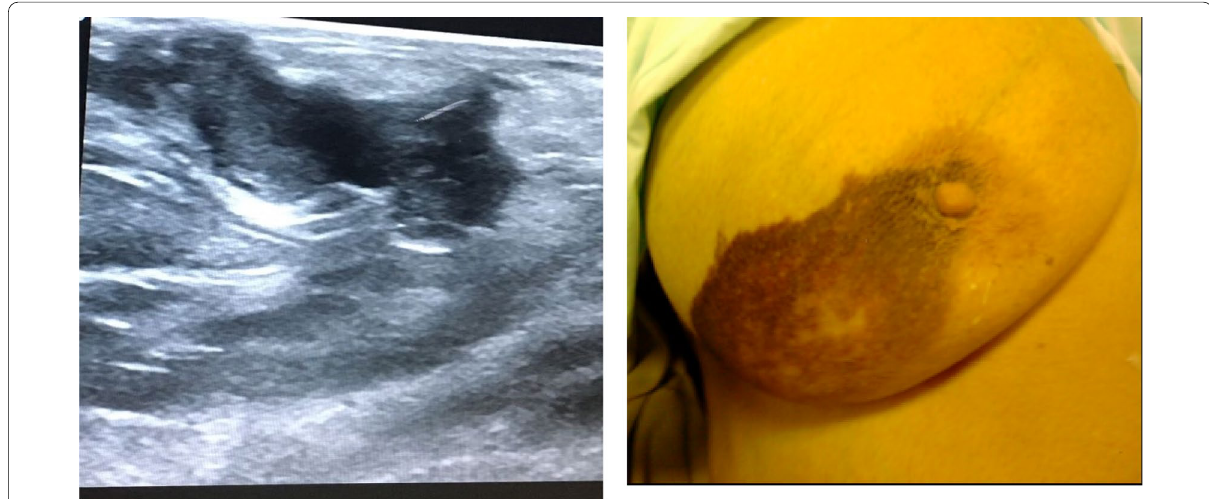
Fig. 3 a , b Breast hematoma evident in ultrasound and clinical examination